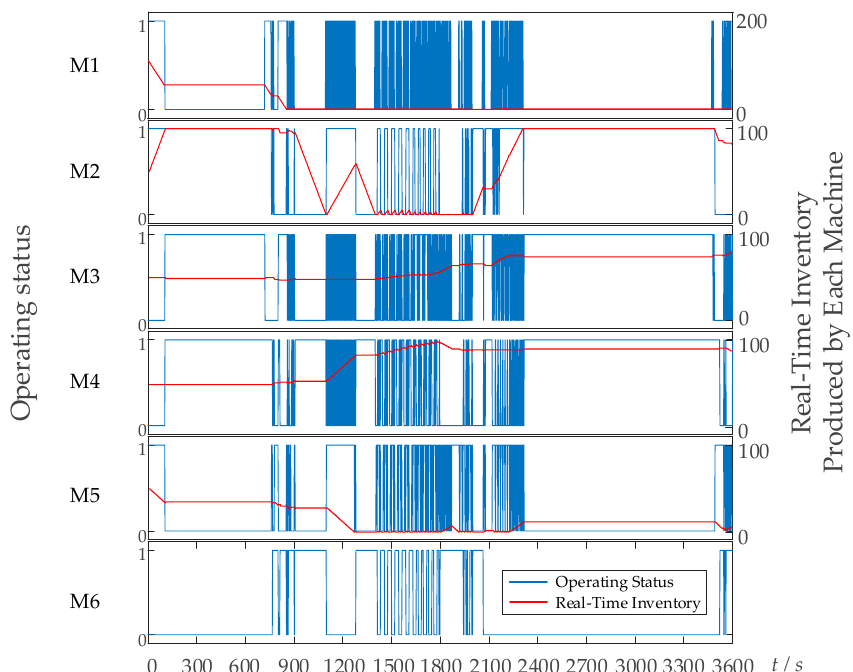
Figure 3. The real-time operating status of each machine and the real-time quantity of each workpiece stored in the flow shop.